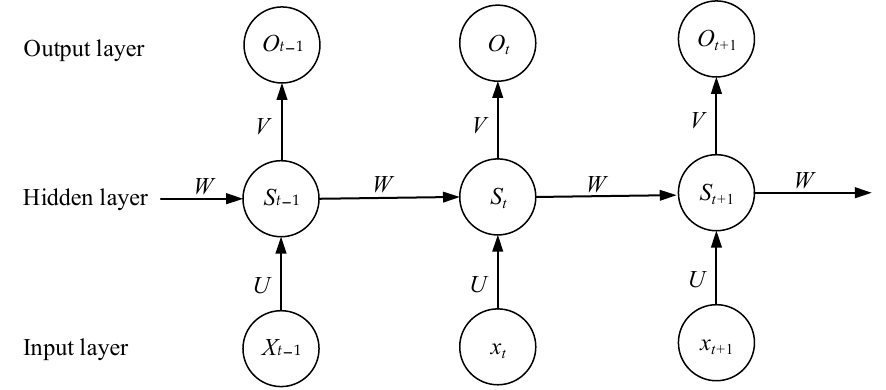
Figure 1. Unfolding action diagram of a RNN model.